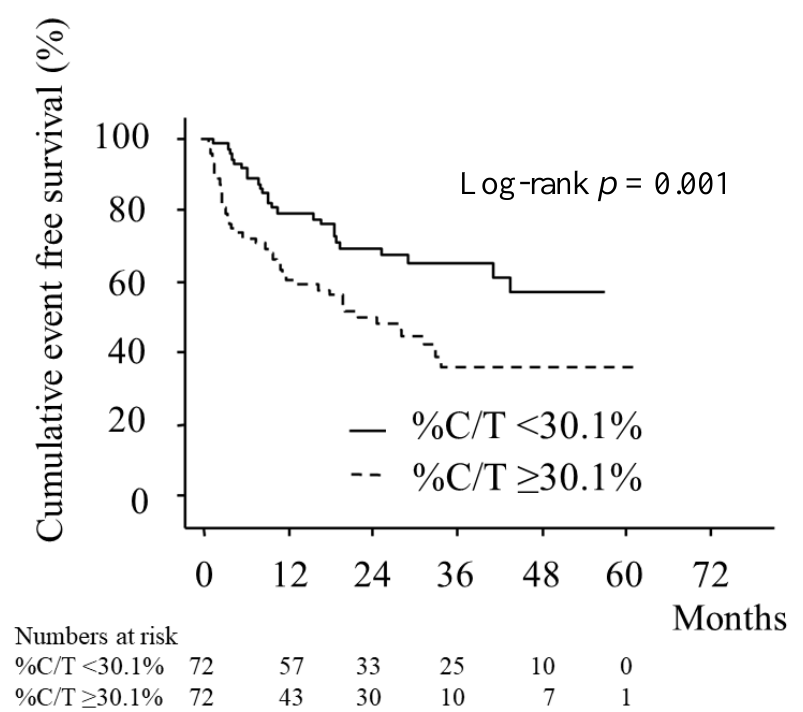
Figure 1. Kaplan–Meier estimation of event-free survival. Legend: Kaplan–Meier estimation of cumulative event-free survival showing a significantly worse clinical outcome in the predominant central sleep apnea group. % C/T, percentage of central to total respiratory events.